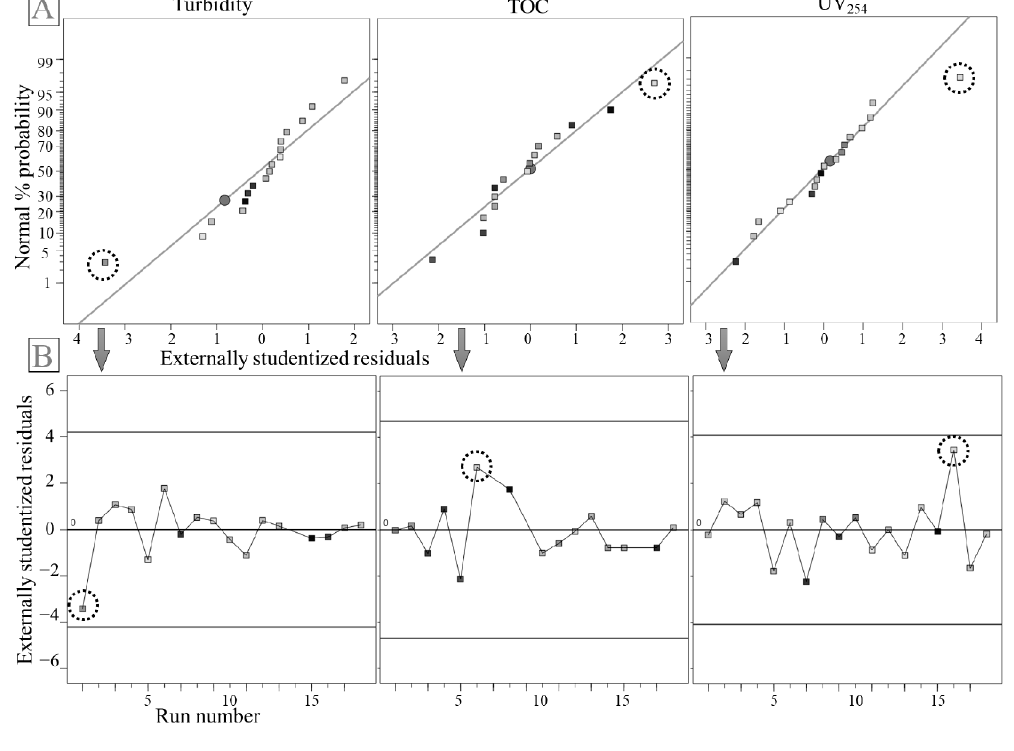
Figure 3. Normal distribution of residuals ( A ) and residuals per run ( B ). Table 4. Enhanced coagulation model fitting at the Montfullà DWTP.